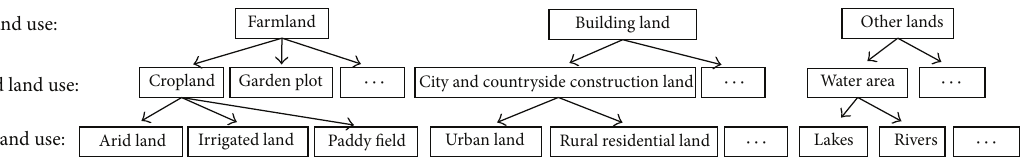
Figure 1: Hierarchical tree of land use type.